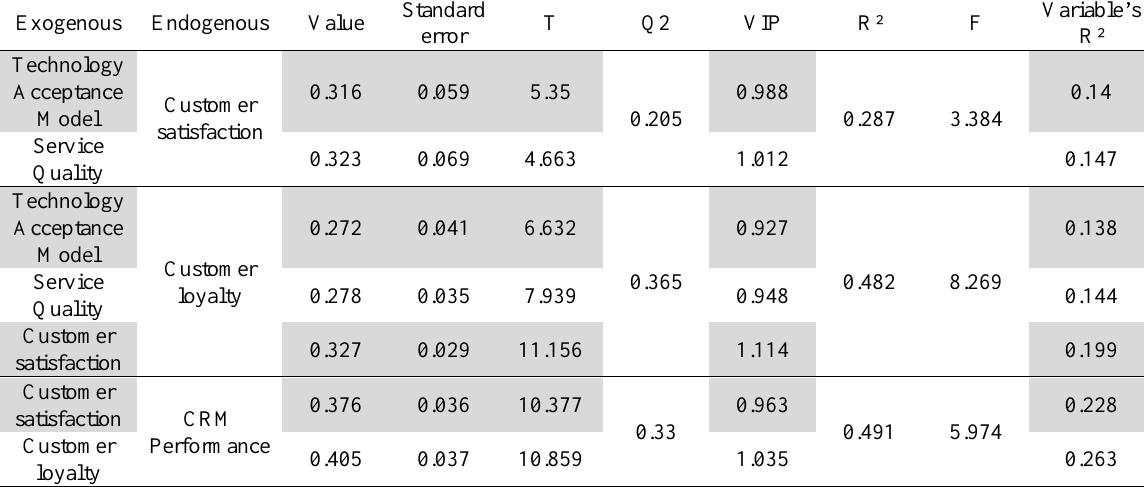
The results of testing various